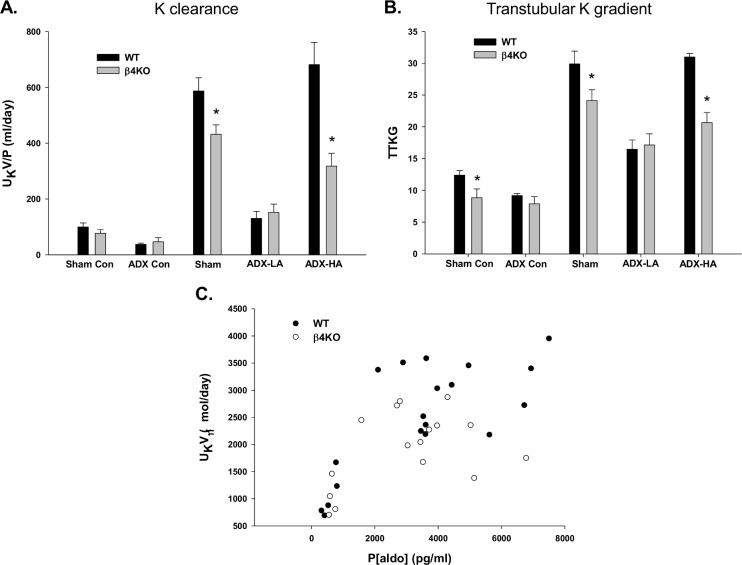
The effect of aldo on β4KO LNaHK mice.The K clearance (A) and TTKG (B) of WT and β4KO mice on Con given sham or ADX surgery or on LNaHK given sham, ADX-LA, or ADX-HA. * P < 0.05 vs. WT. (C) The relation between P[aldo] and UKV determined in WT and β4KO ADX mice receiving various doses of aldo replacement.